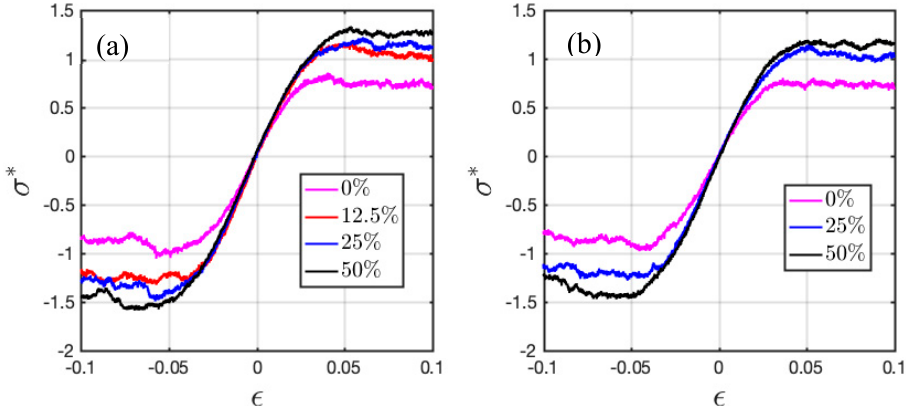
Figure 5. Stress-strain behavior of ( a ) ionic HPs and ( b ) di-BCPs deformed in the parallel to the interface direction at T ∗ = 0.3.